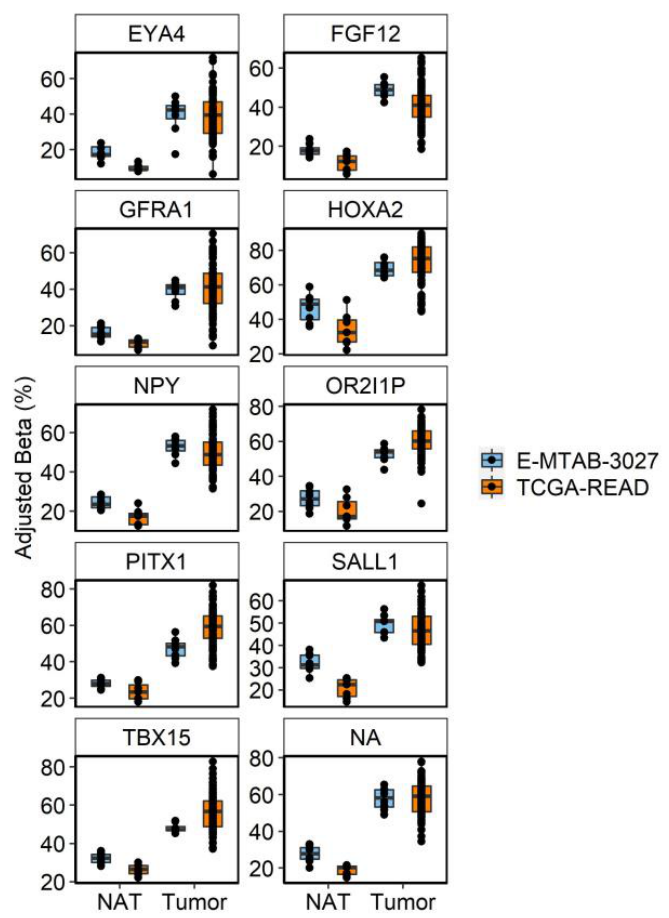
Figure 4. Boxplots of the 10 most significant age-DMRs identified in analysis of RC tumors and NAT in TCGA-READ (orange) and E-MTAB-3027 (blue). Betas were adjusted for technical covariates (sentrix ID and/or sentrix position) prior to plotting using the COMBAT function of the ChAMP package. Individual cytosines within each DMR were averaged on a per sample basis to display the consistency of the average effect of differential methylation at that region across samples.